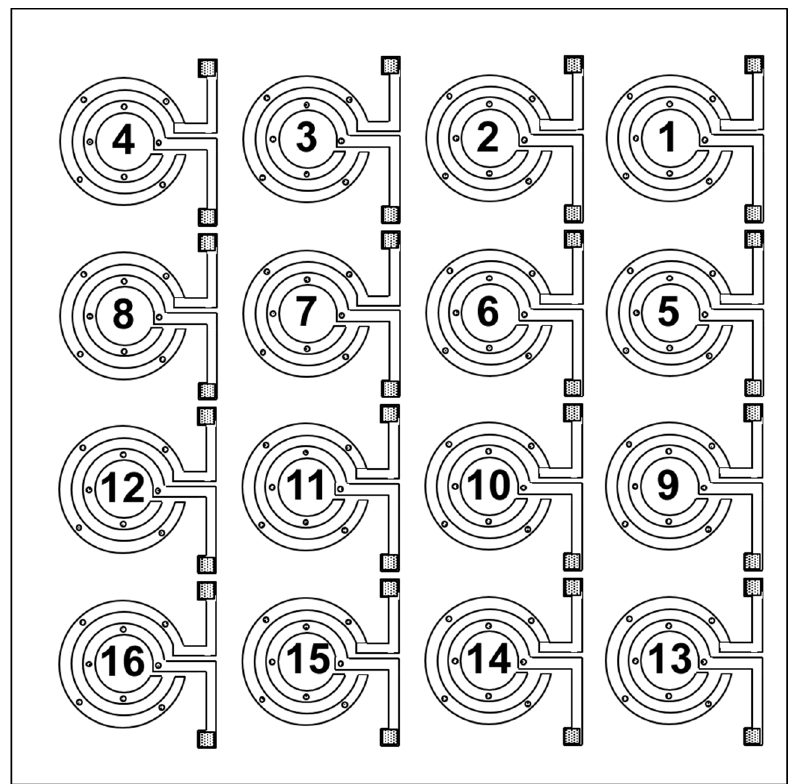
Figure 8. Schematic representation of the 16-channel chemosensitive resistor device used in this part of the study. The numbers denote individual chemosensitive resistor elements coated with appropriate composite (see Table 4 for details).